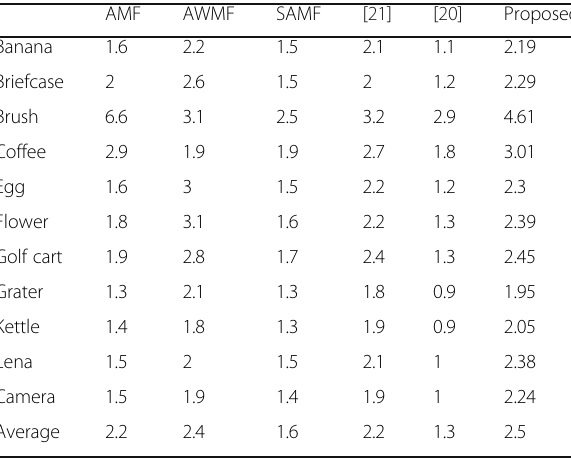
Table 10 CPU elapsed time comparison for 30% noise